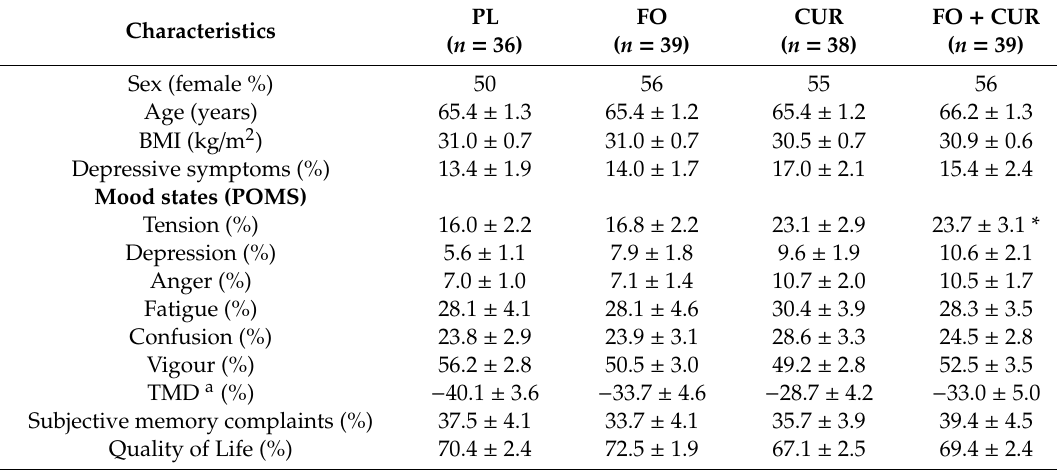
Table 1. Participants’ baseline characteristics per group.